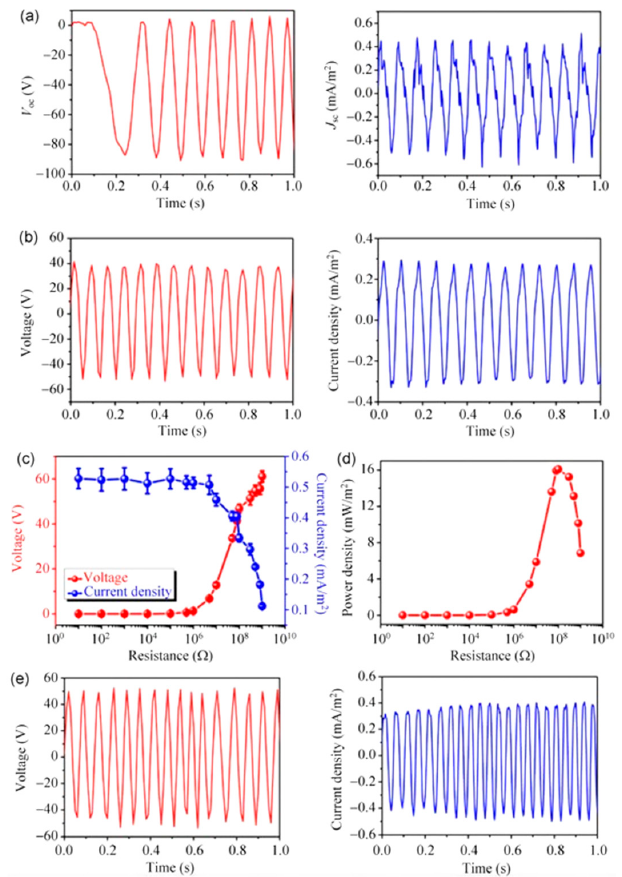
Figure 12. ( a ) Experimental results of the open-circuit voltage and short-circuit current density of the TENG using one strip unit. ( b ) Output voltage and current density of the TENG with one strip unit considering a load resistance of 100 M Ω . ( c ) Variation in the output voltage and current density of the TENG as a function of load resistance. ( d ) Response of the power density as a function of load resistance. ( e ) Output voltage and current density of the TENG with two strip units. Reprinted with permission from [157]. Copyright 2014, Tsinghua University Press and Springer ‐ Verlag Berlin Heidelberg.